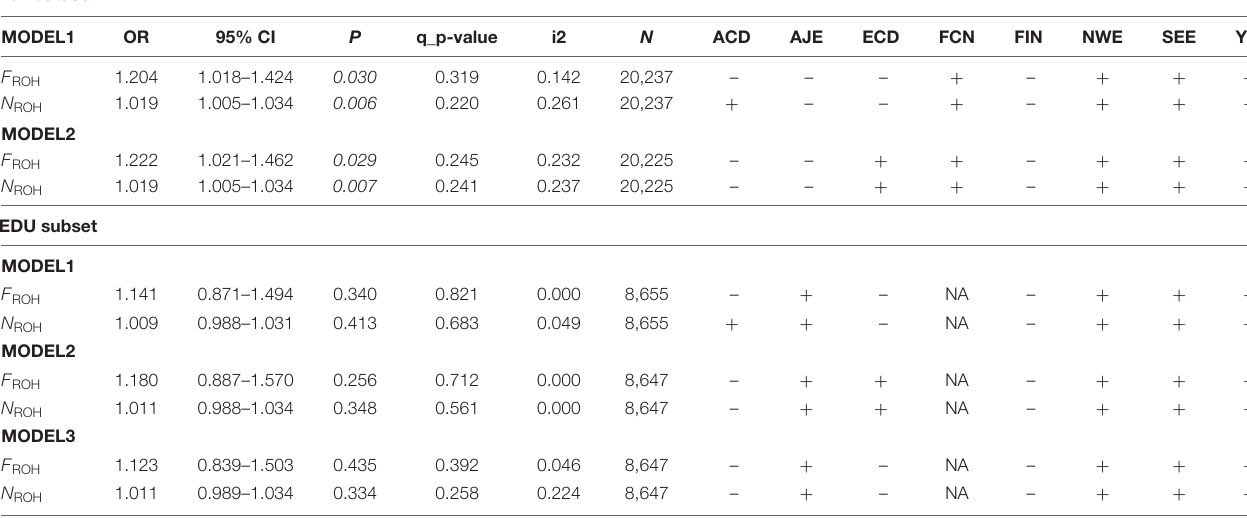
TABLE 4 | Autozygosity in the outbred population increases the risk of